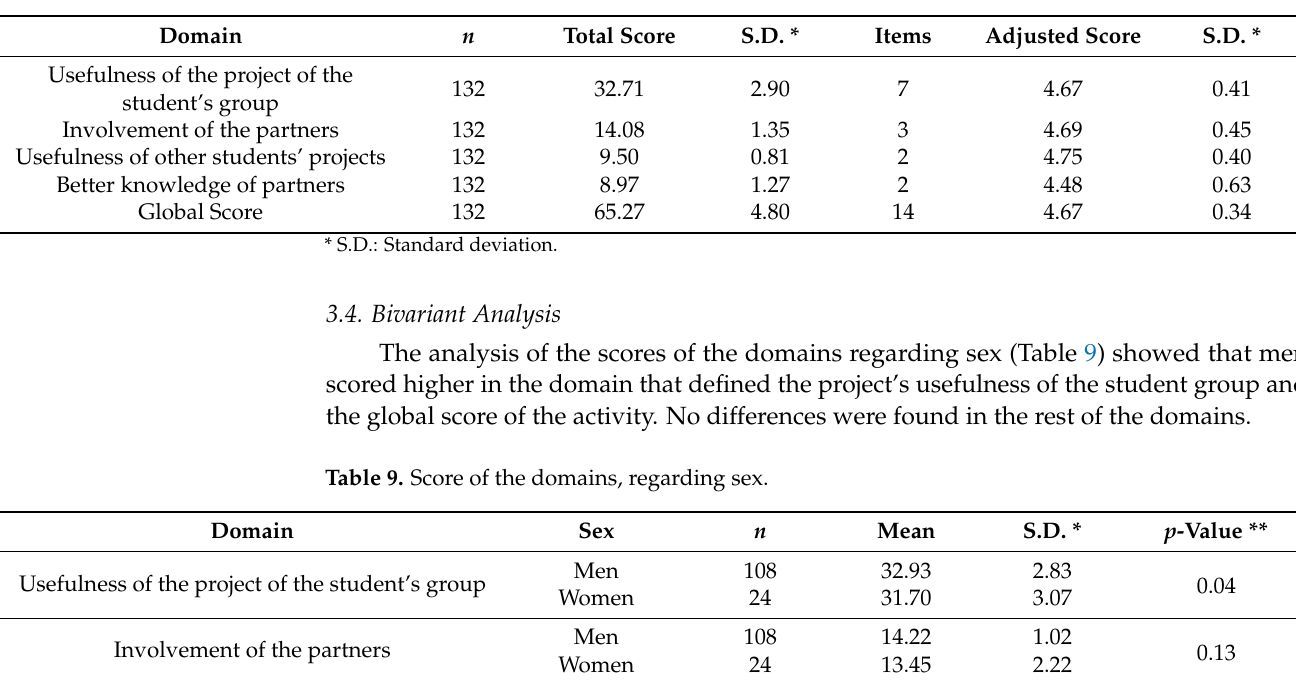
Table 8. Total score of the domains, adjusted by the number of items.